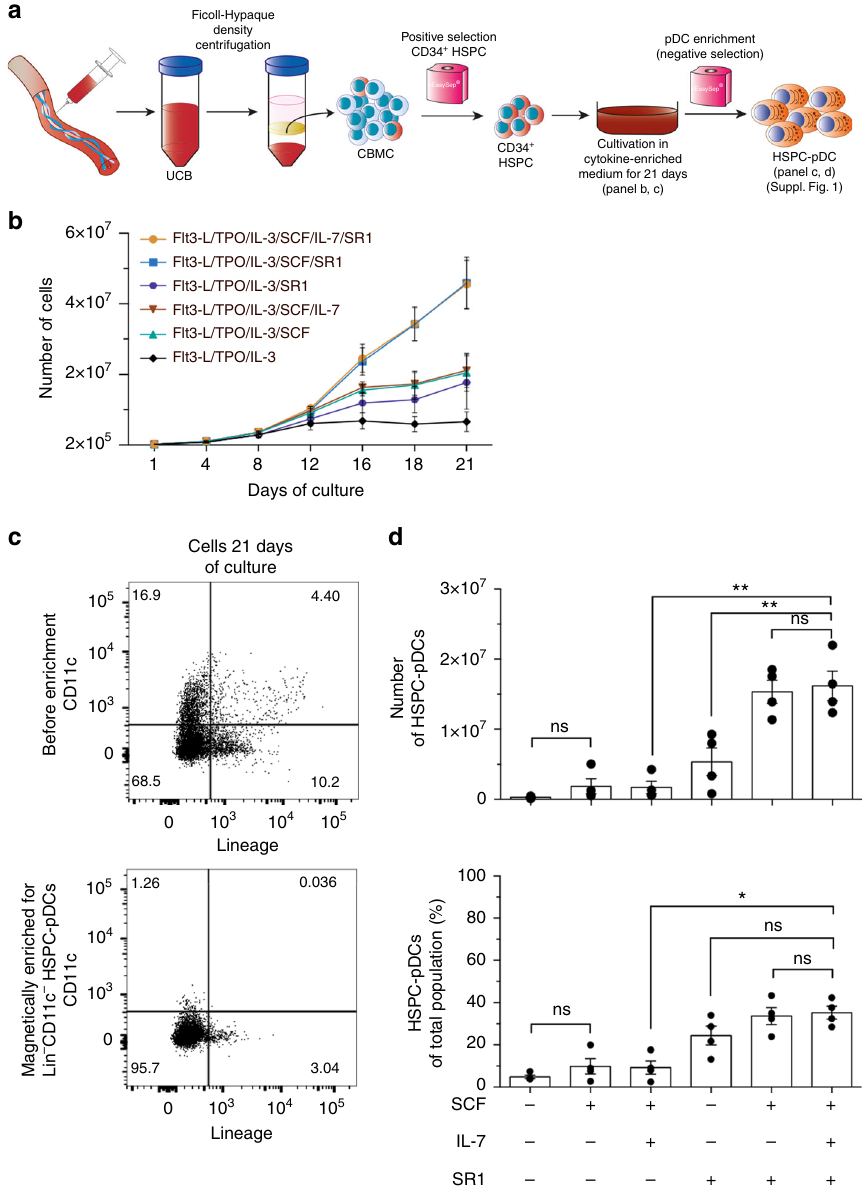
Fig. 1 Generation of pDCs from hematopoietic stem and progenitor cells (HSPC-pDC). a Graphical illustration of the generation of HSPC-pDCs from HSPCs. CD34 + HSPC were isolated from human umbilical cord blood (CB). Brie fl y, cord blood mononuclear cells (CBMC) were recovered by Ficoll- Hypaque density-gradient centrifugation. CD34 + HSPCs were then isolated using anti-CD34 immunomagnetic beads. Next, 2 × 10 5 CD34 + HSPC were cultivated for 21 days with factors promoting the expansion and differentiation of cells. At day 21, the cell suspension was magnetically enriched for lin neg CD11c neg pDCs using negative immunomagnetic selection. b Total numbers of suspension cells measured at the experiment start (day 1) and the consecutive culture days (4, 8, 12, 16, 18, and 21) with the indicated factors in the medium. c Representative fl ow cytometry plots showing lineage and CD11c markers before and after enrichment of pDCs. d Total numbers (upper panel) or percent yield (lower panel) of HSPC-pDCs generated after magnetic enrichment (negative selection) at day 21 from Flt3-L, TPO, IL-3 culture supplemented with indicated growth factors. Error bars represent ± SEM of four donors. Statistical analysis was performed using one-way ANOVA ( d ) followed by Bonferroni post hoc